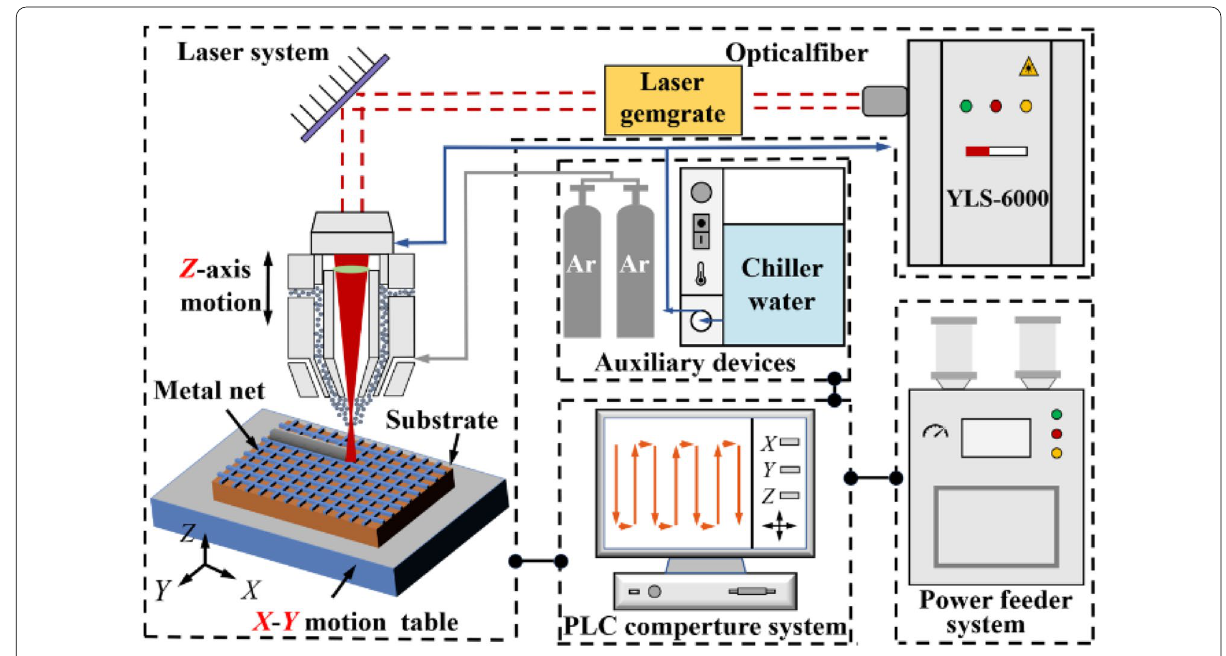
Figure 3 A schematic illustration of the laser cladding process